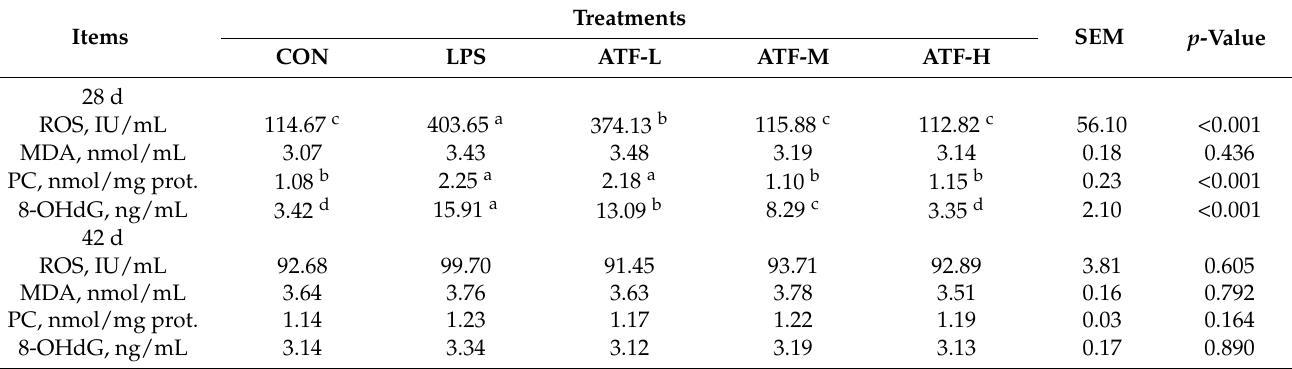
Table 4. Effect of ATF on serum ROS and oxidative byproducts in broilers challenged with LPS.